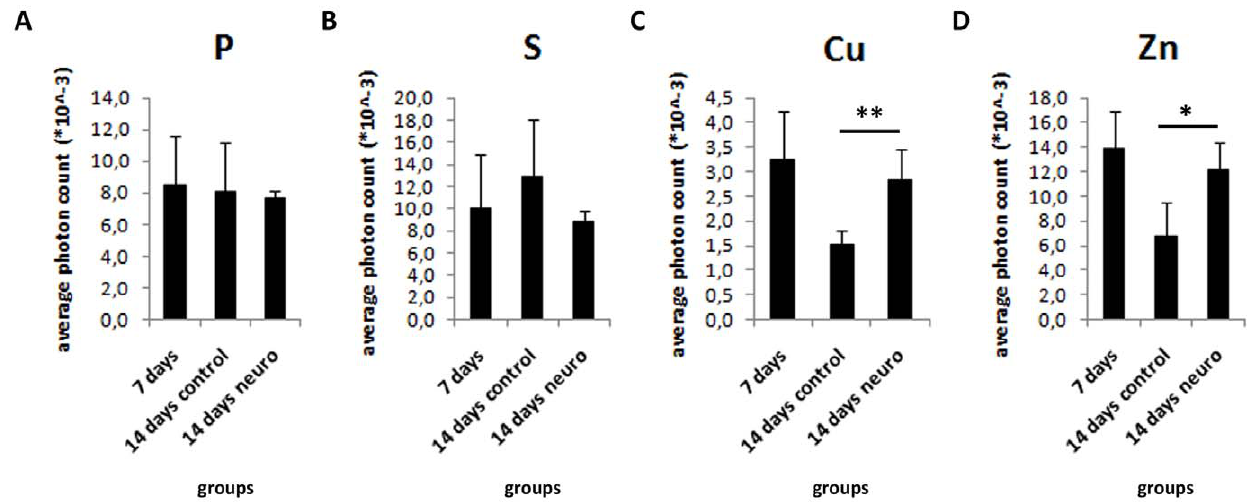
Figure 11. Human embryoid bodies show similar levels of P, S, Cu and Zn at different stages of differentiation. Measure of elemental content normalized per irradiated area, A) P; B) S; C) Cu; D) Zn, *p , 0.05; **p , 0.01.